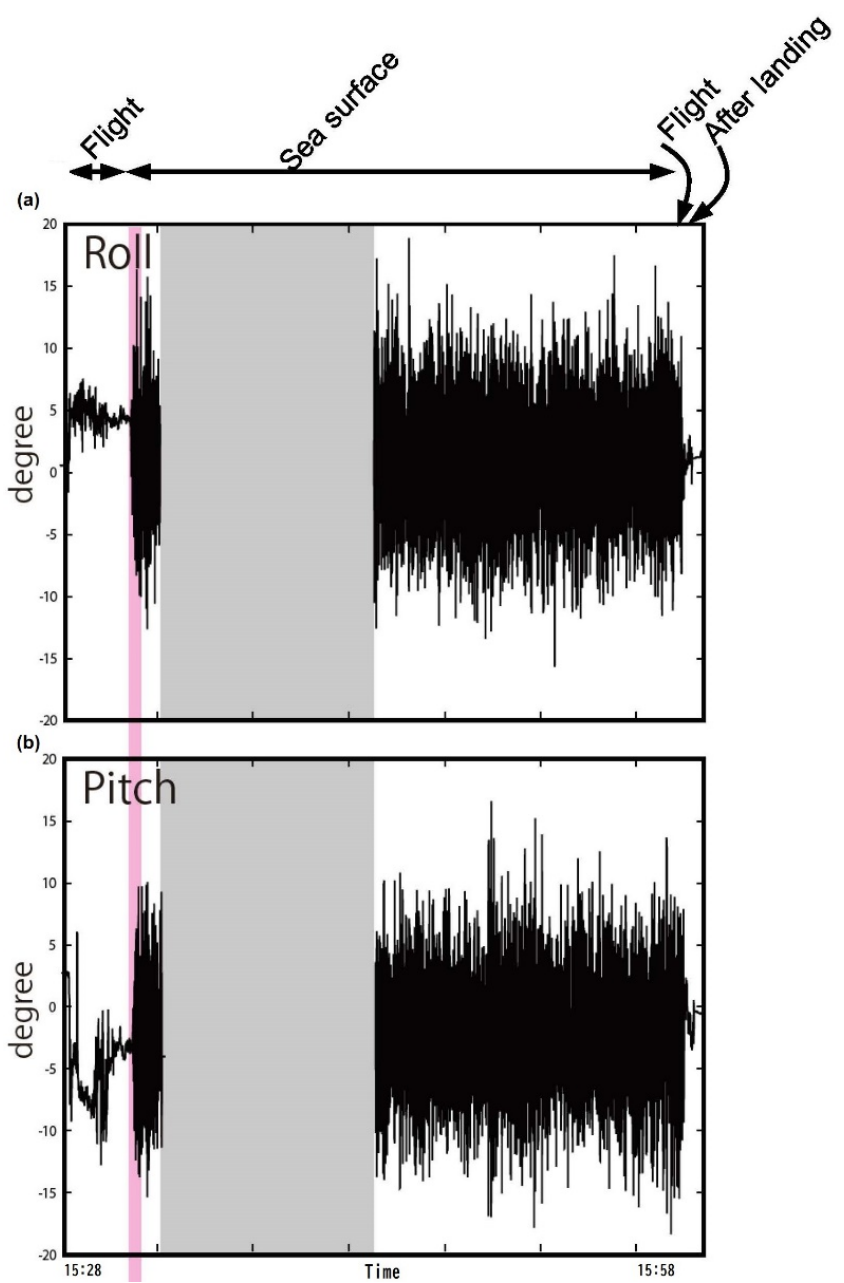
Figure 8. IMU recording of the (a) roll component and (b) pitch component for about 30 min. The horizontal axis is time (JST, UTC+0900). During the period with gray shading, no data were acquired. Red shading denotes the period of landing on the sea surface.